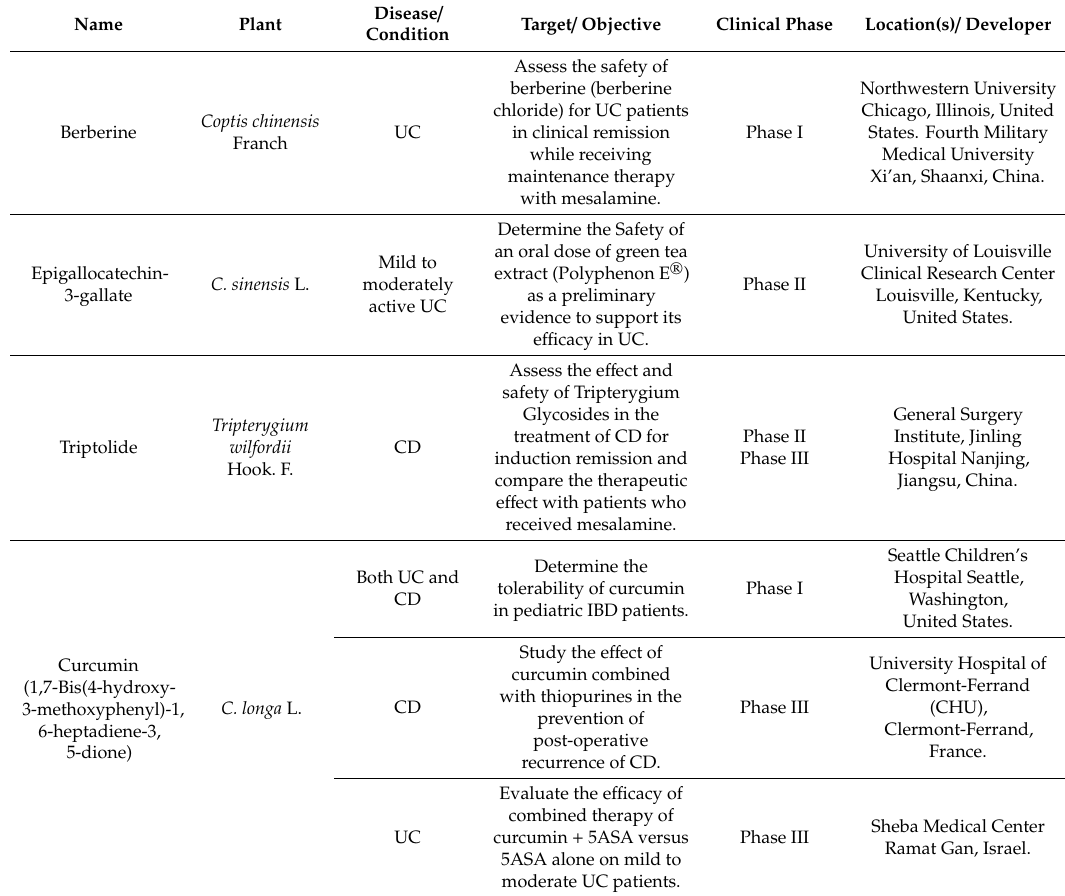
Table 2. Plant-derived compounds in various phases of clinical trials for Inflammatory Bowel Diseases a